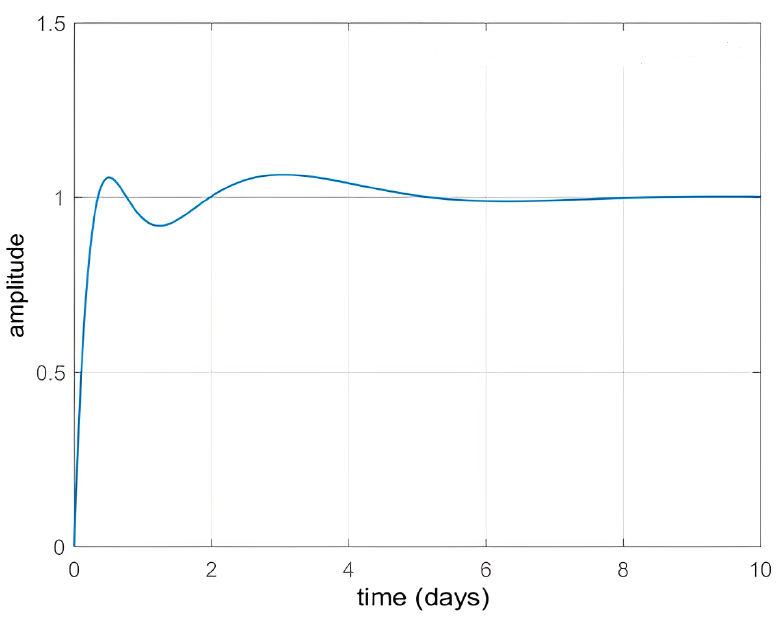
Figure 8. Plot of the step response for a Skogestad-IMC PID